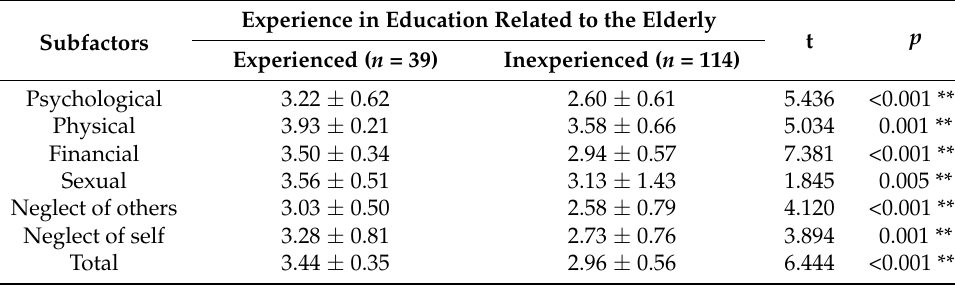
Table 3. Perceived degrees of violation of human rights of the elderly according to the experience of receiving education related to the elderly M ±